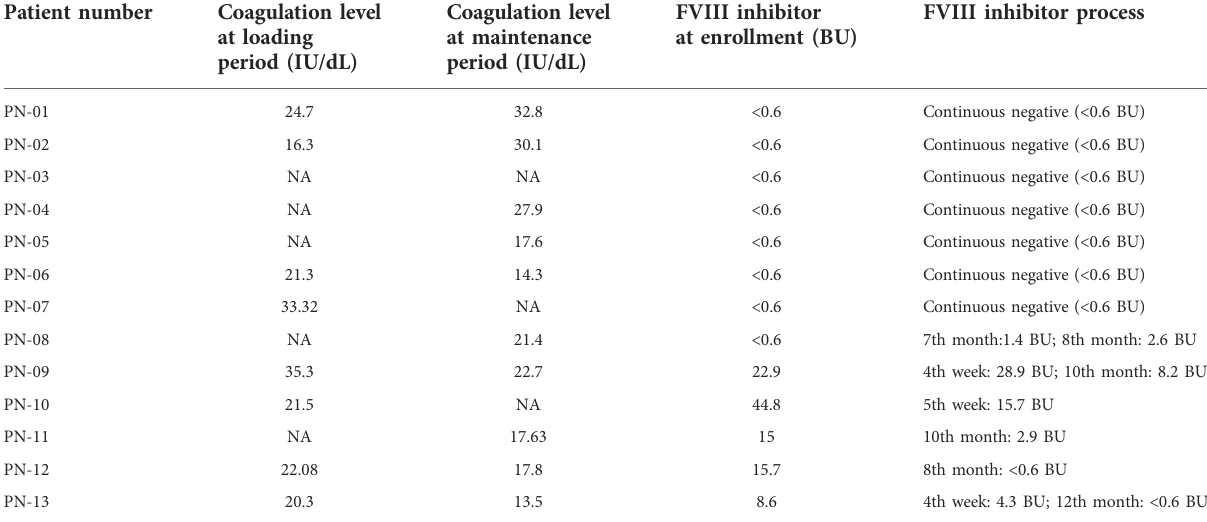
TABLE 2 Patients ’ coagulation level and inhibitor development